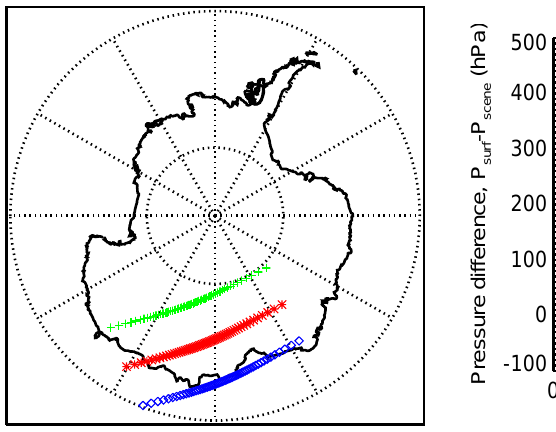
Fig. 1. Left: three OMI scan lines (iLine = 300, 350, and 400) over Antarctica for OMI orbit 12394 on 13 November 2006. Right: difference between surface pressure, P (pressure of a Lambertian surface that provides the observed amount of rotational-Raman scattering – see text for details) for these scan lines as a function of OMI cross-track position. figure